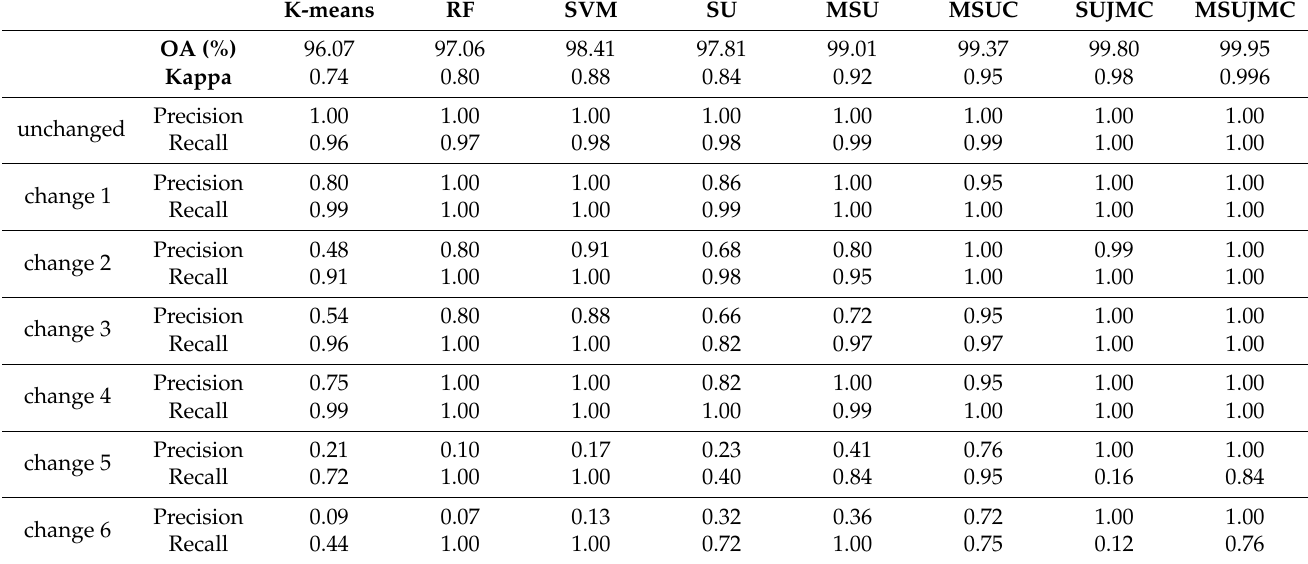
Table 2. Accuracy statistics of simulation